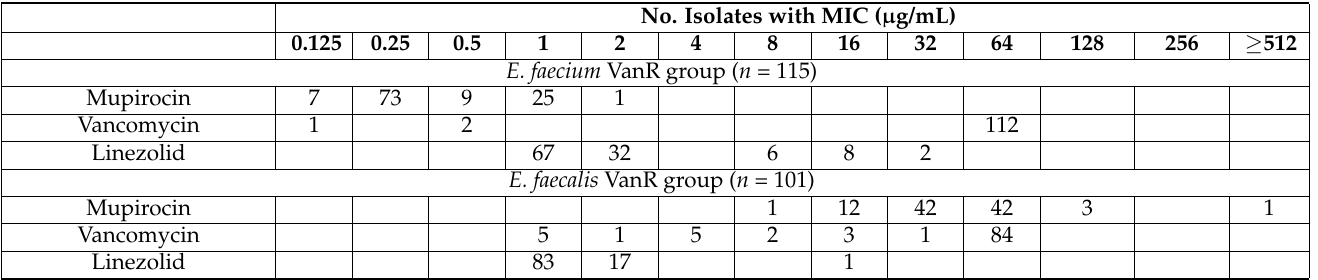
Table 3. Mupirocin activity against vancomycin-resistant E. faecium and E. faecalis isolates: PHE data.